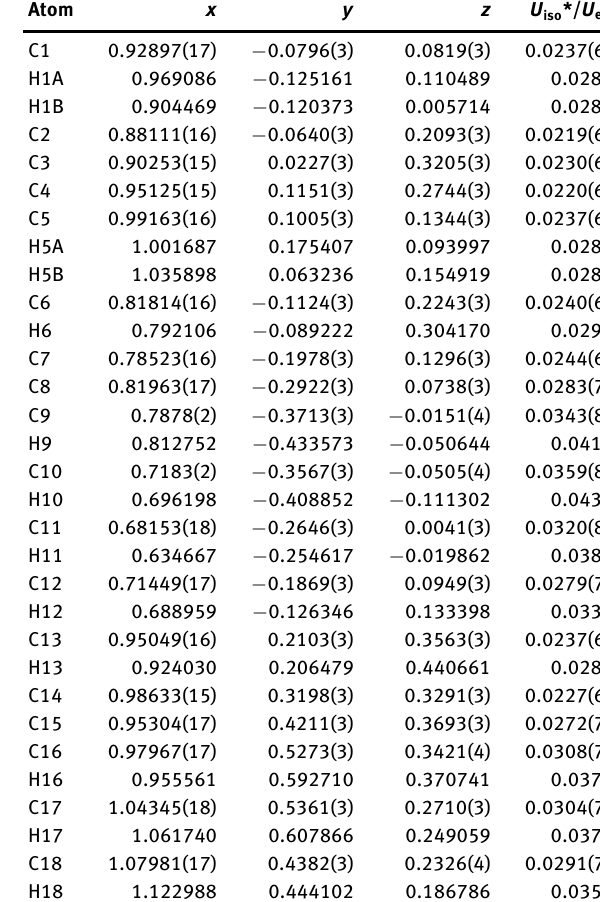
Table 2: Fractional atomic coordinates and isotropic or equivalent isotropic displacement parameters (Å 2